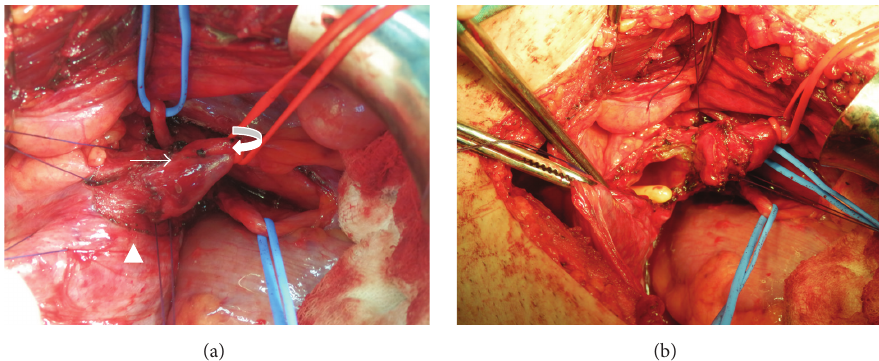
Figure 3: Preoperative and postoperative images of the patient (a and b). AVF (arrow) was seen in appendix (curved arrow) and was attached to bladder wall (arrow head) in preoperative